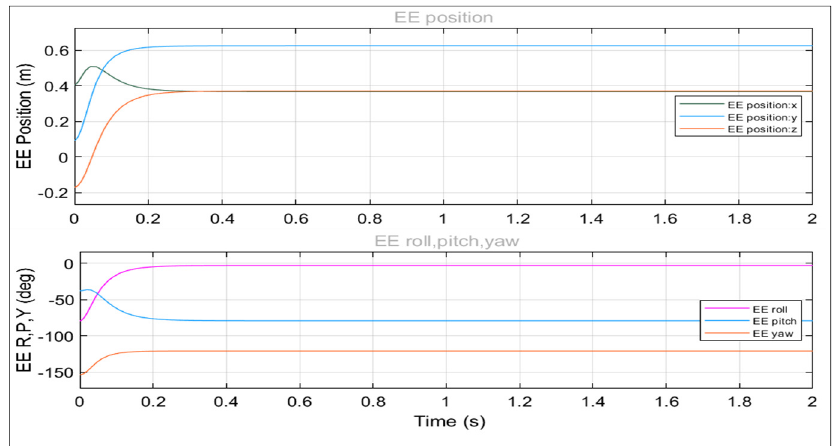
Fig. 9. End Effector Cartesian Position and